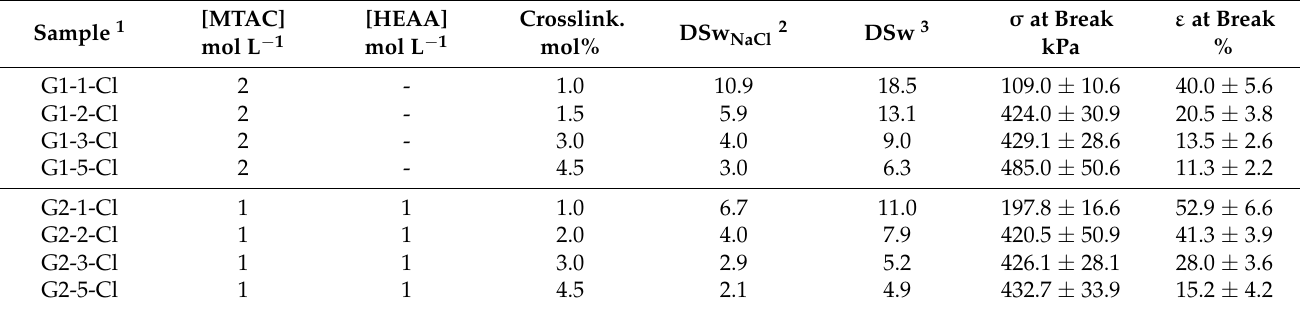
Table 1. Hydrogel composition, swelling, and mechanical